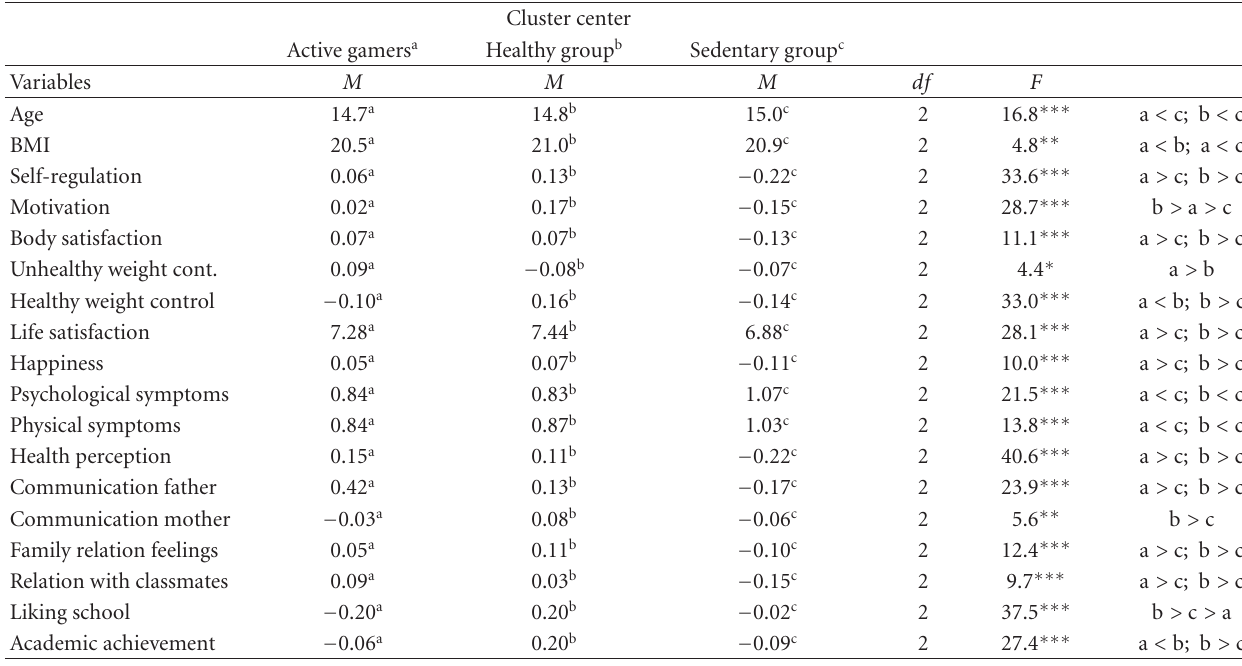
Table 2: Di ff erences between clusters for each psychosocial variable.